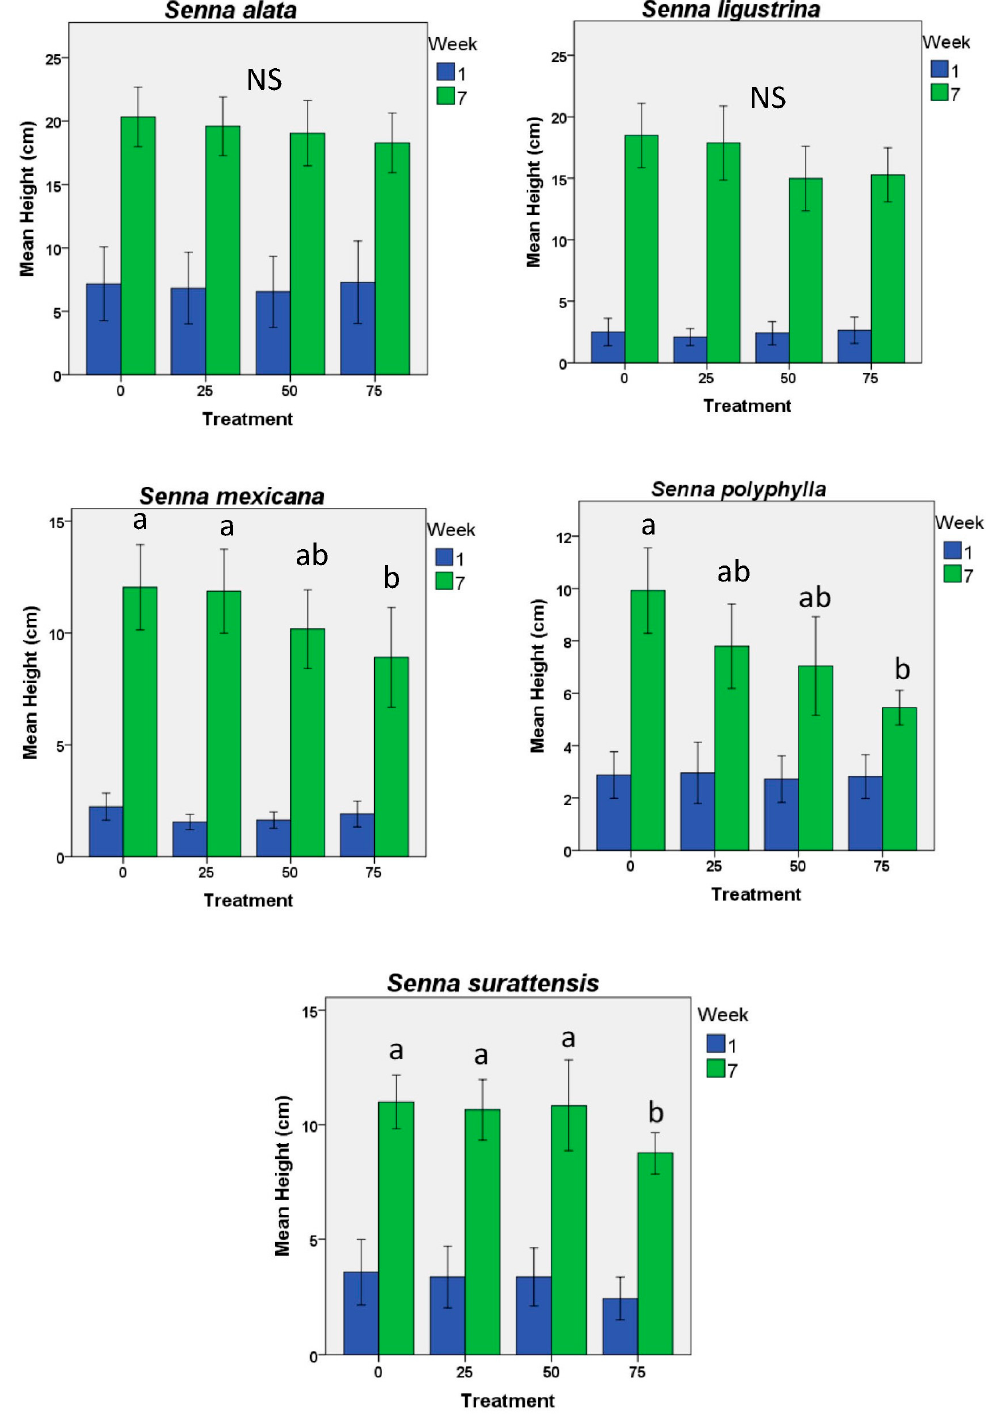
Figure 1. Heights—mean (+2 S.E.) beginning and final heights of five species of Senna subject to different levels of artificial defoliation over the first two months of life (n = 22 plants each level and control). In no case were the initial heights different among the treatment groups. Small letters by bars indicate significant differences ( p < 0.05); bars with the same letters do not differ significantly from each other. NS indicates no significant differences found.